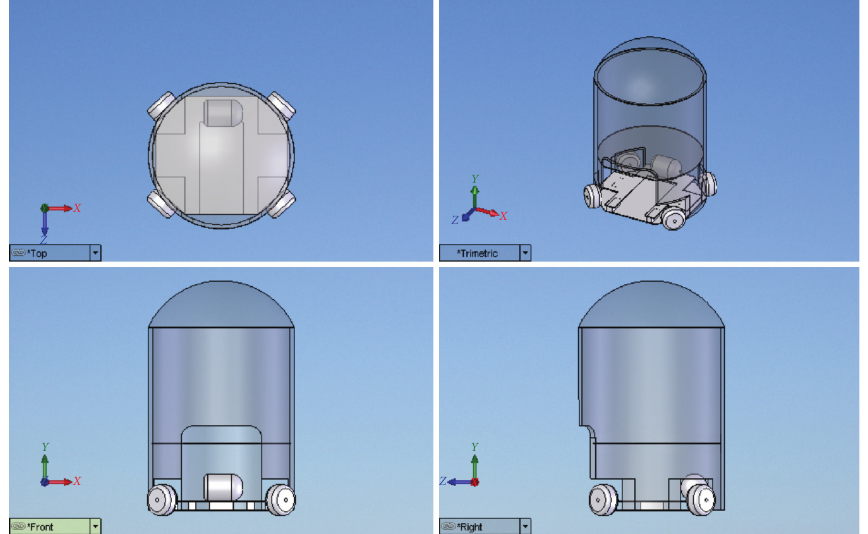
Figure 4: Conceptual design 3: Bullet design with a pneumatic kicker.